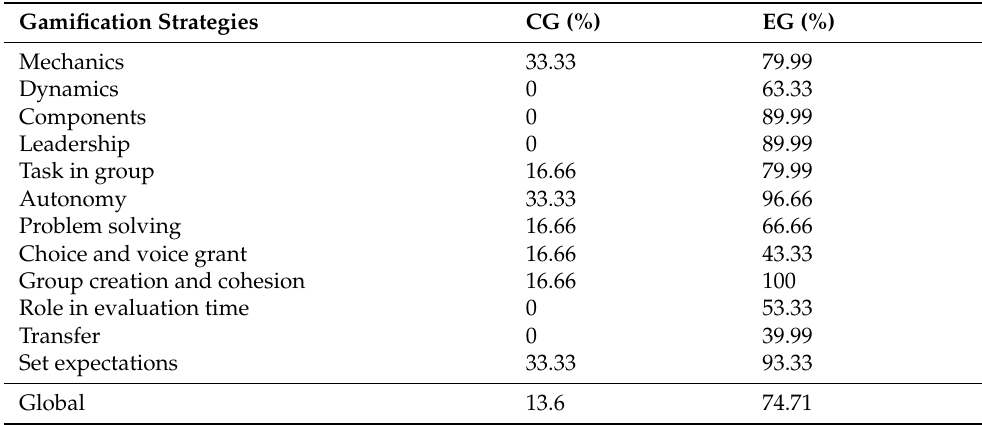
Table 1. Differences between groups in the strategies used. CG: control group and EG: experimental